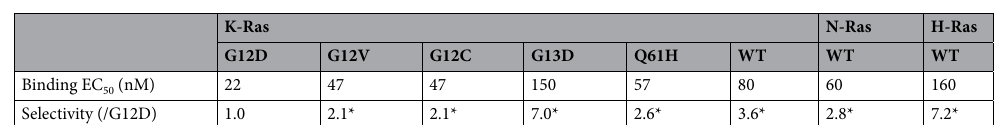
Table 3. Binding EC 50 values of Biotin-KS-58 to Ras proteins. EC 50 values are listed as average values calculated from Fig. 4B. * p < 0.05 by Dunnett’s multiple comparison test.